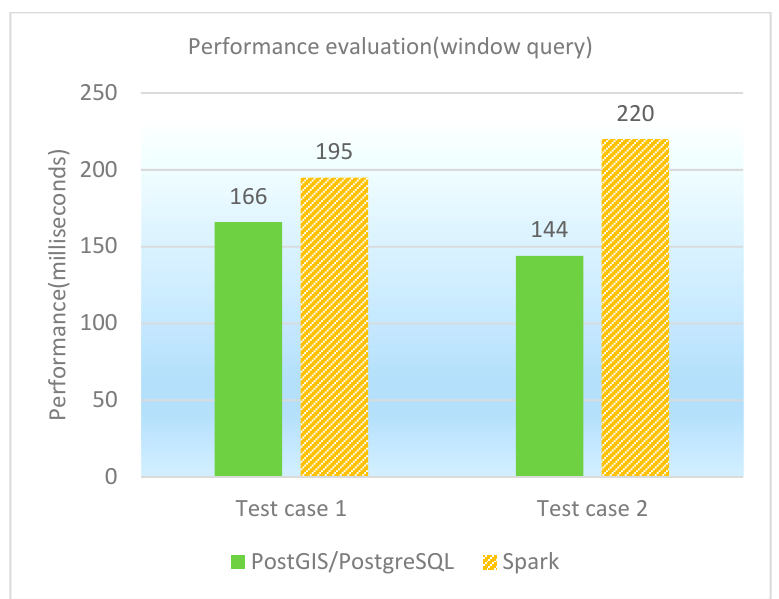
Figure 8. Performance comparison graph of window queries (in milliseconds).